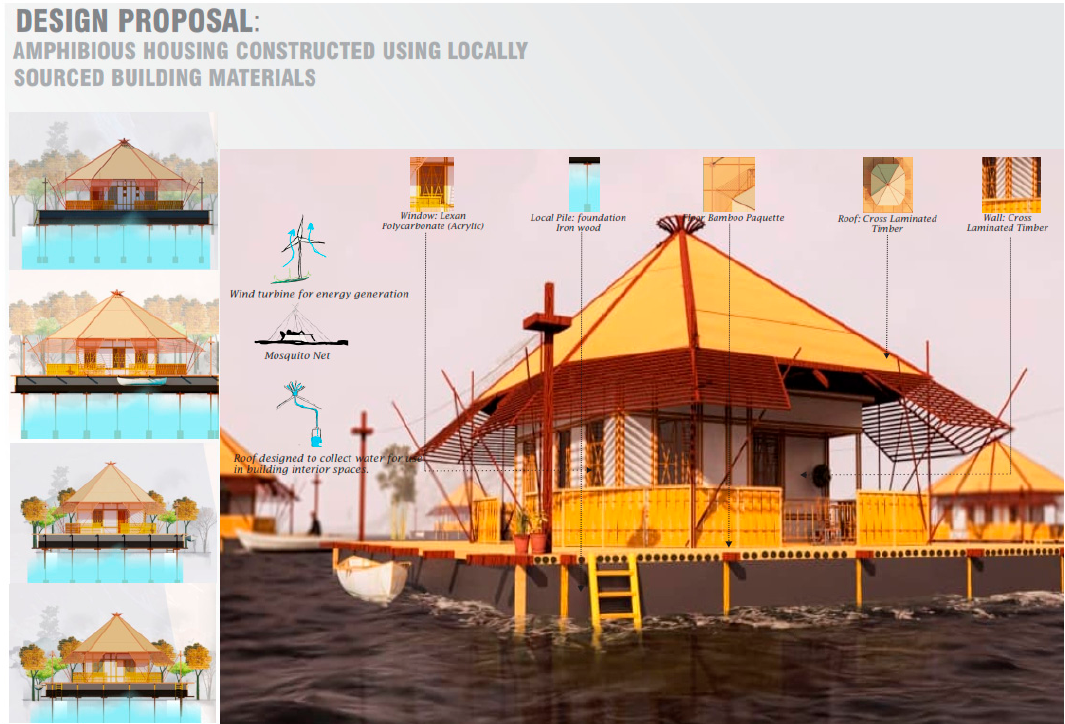
Figure 7. Group D’s proposal for a building constructed using local materials. Source: CR4D Charette Team, 2019.